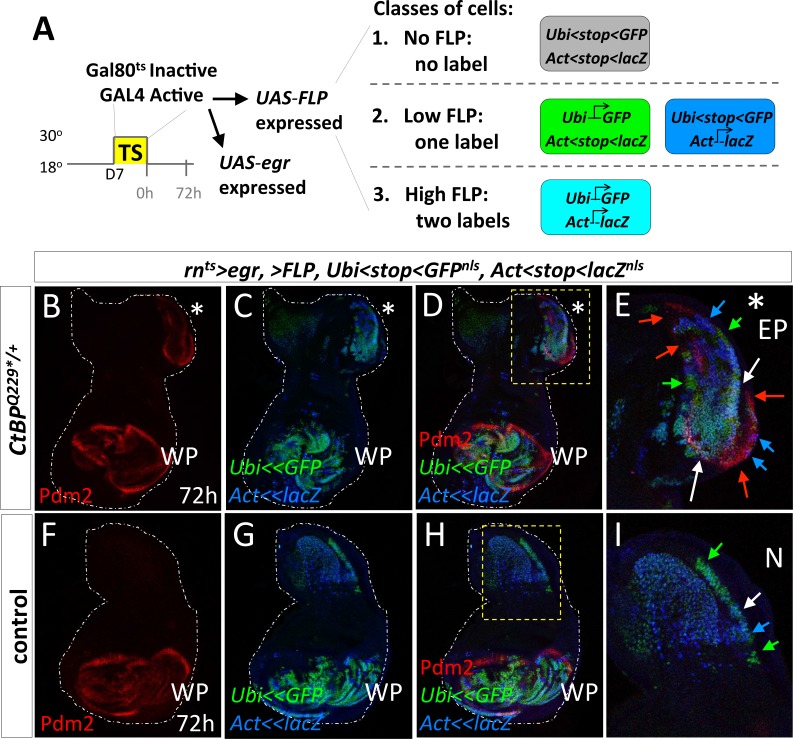
The regenerating wing pouch and ectopic pouch are derived from cells that express rn-GAL4 during the ablation period.(A) Diagram of the system used to lineage label cells that express rn-GAL4 during the ablation period. When shifted to the higher temperature (30°C), rn-GAL4 drives the expression of both UAS-egr and UAS-FLP. There are two independent FLP-out constructs (Ubi<stop<GFP and Act<stop<lacZ). There will be several possible classes of cells: (1) cells that do not express rnts>FLP and remain unlabeled, (2) cells that express low levels of rnts>FLP during the temperature shift and stochastically activate one construct (either express GFP or β-GAL alone), and (3) cells that express high levels of rnts>FLP and activate both flip-out constructs (express GFP and β-GAL). (B–I) Wing discs following 72 hr of recovery from rnts>egr ablation with an ectopic pouch (B–E) and without an ectopic pouch (F–I), as shown by pouch marker Pdm2. The wing pouch (WP) is largely regenerated from cells that expressed rnts>egr and UAS-FLP during the temperature shift. The ectopic pouch (EP) and notum (N), as highlighted in dotted rectangle in (D, H) are enlarged in (E, I) to show the classes of cells present. Green arrow = GFP only, Blue arrow = β-GAL only, White arrow = GFP and β-GAL and Red arrows are unlabeled regions that express Pdm2.